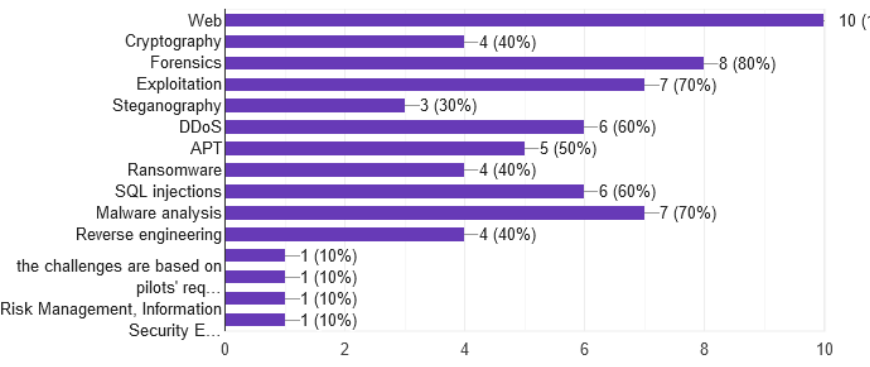
Figure 4. Security challenges of the Cyber Range.